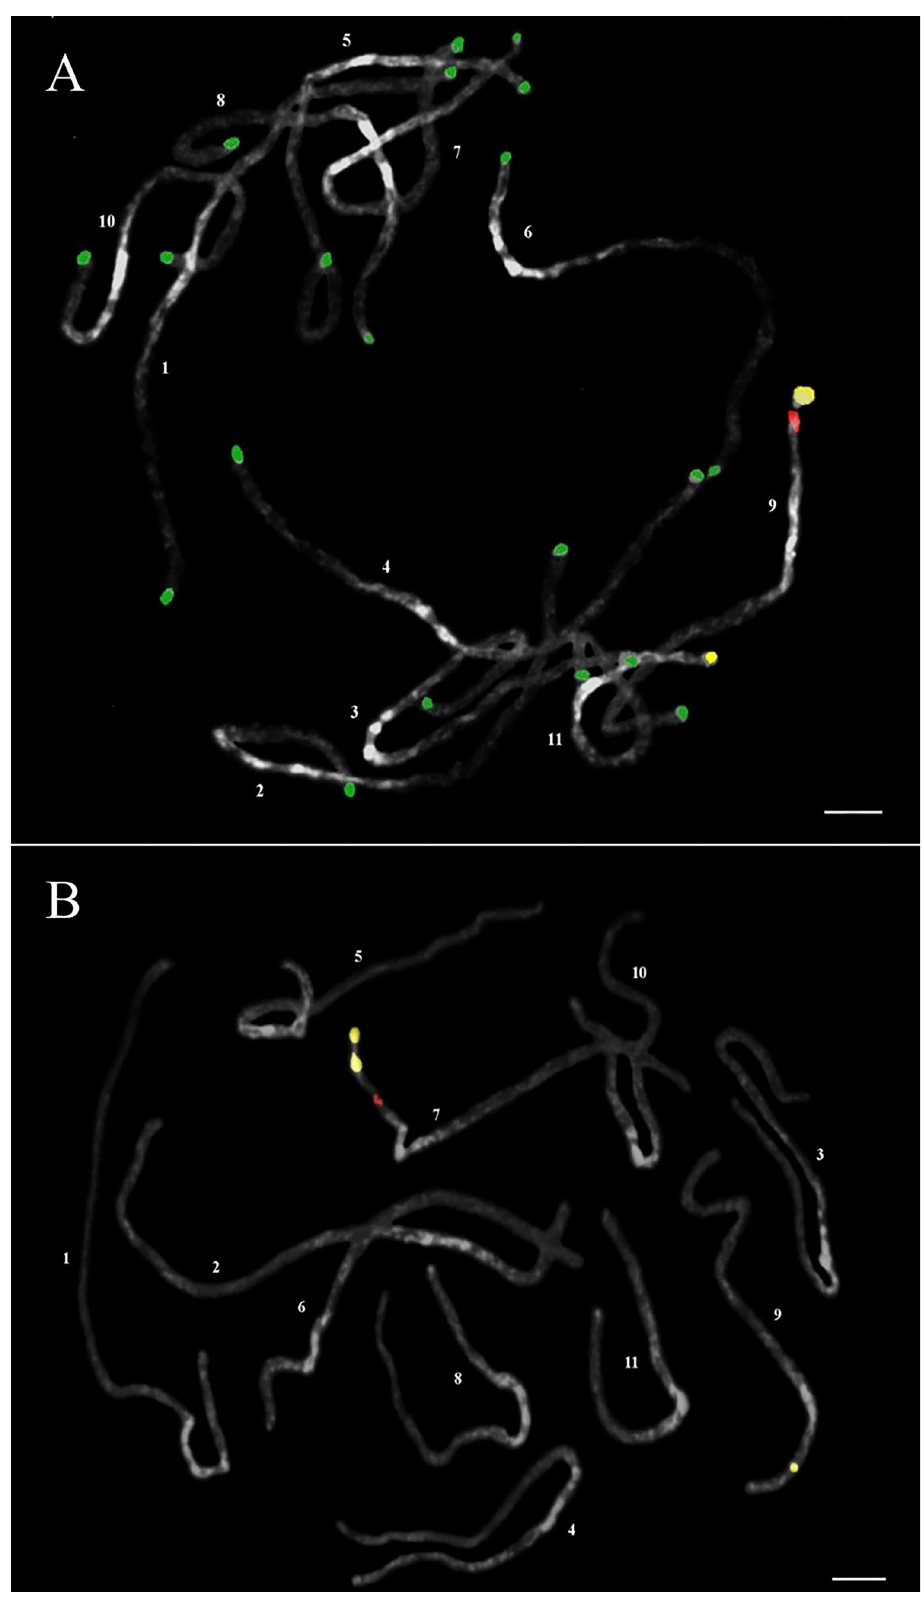
Fig 3. FISH signals on pachytene chromosomes of J . curcas (A) and J . integerrima (B) based on 5S rDNA (red signal), 45S rDNA (yellow signal) and JcSat1 DNA (green signal). Bar = 5 μ m. https://doi.org/10.1371/journal.pone.0208549.g003 PLOS ONE | https://doi.org/10.1371/journal.pone.0208549 December6,